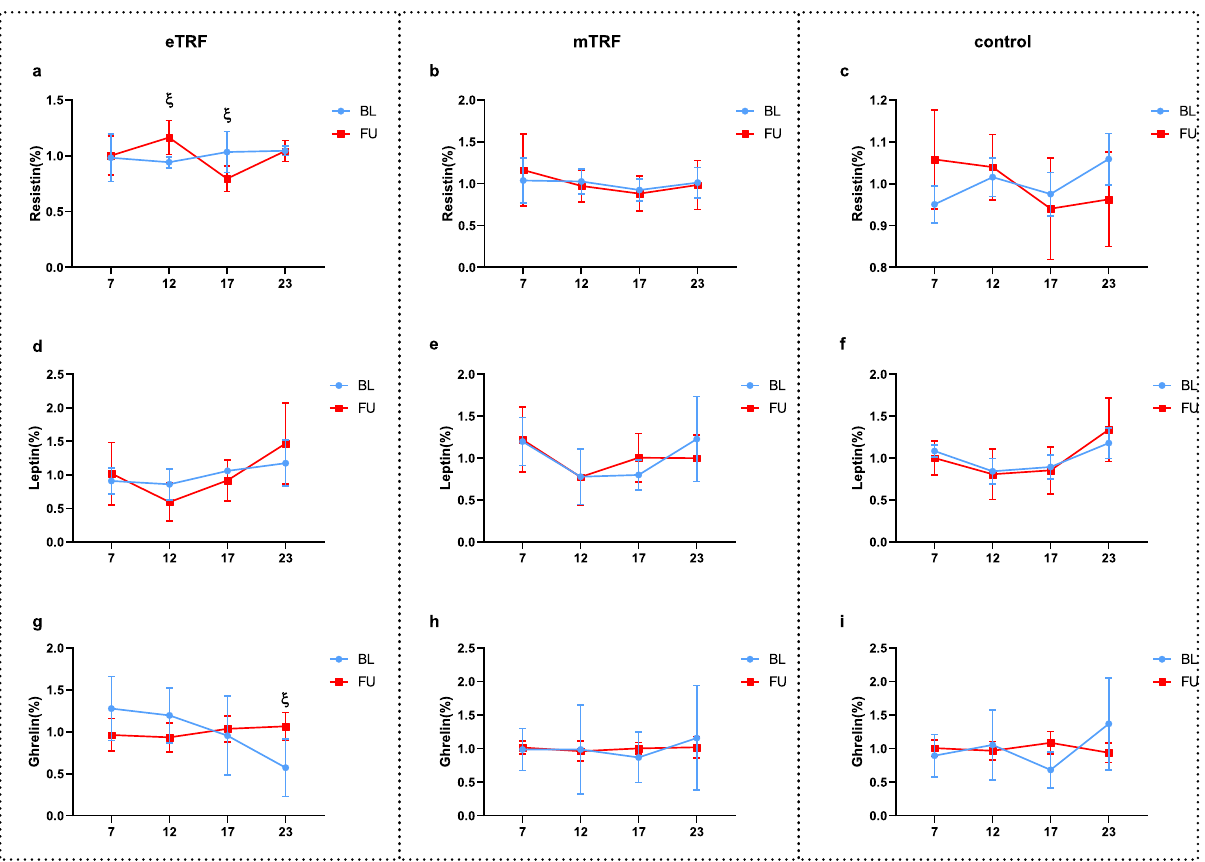
Fig. 3 Only eTRF, but not mTRF, in fl uenced the daily rhythms of plasma adipokine concentrations. At baseline and at the end of the study, samples were collected from 19 participants (eTRF, n = 5; mTRF, n = 8; and control, n = 6). Plasma adipokine concentrations (resistin, leptin, and ghrelin) were measured at four time points. Two-way ANOVA analysis showed that eTRF ( a , d , g ) caused signi fi cant changes in the resistin concentration at 12:00 ( p = 0.048) and 17:00 ( p = 0.03) ( a ), and in the ghrelin concentration at 23:00 ( p = 0.037) ( g ), but mTRF ( b , e , h ), or control groups ( c , f , i ) had no signi fi cant effects on the rhythm of adipokines. The values at each time point are displayed as the percentage of the mean value across all the time points and are displayed as means ± SEMs. Two-way repeated-measures ANOVA with time of day and feeding regimens as the two independent variables. ξ p < 0.05 between baseline and follow-up at that time point. BL baseline, FU follow up.